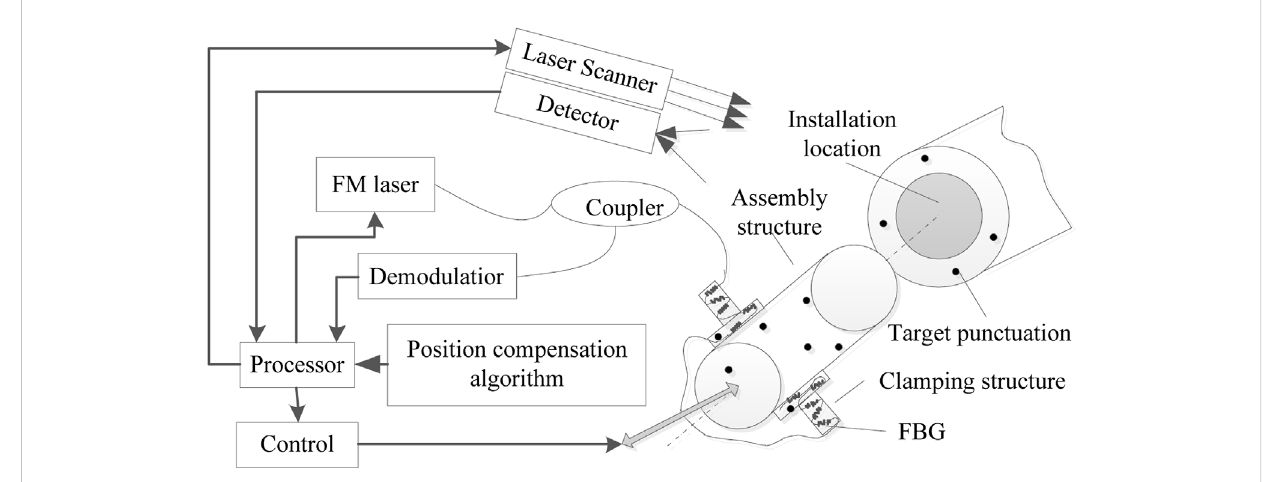
FIGURE 1 Based on laser scanning and optical fi ber detection and correction